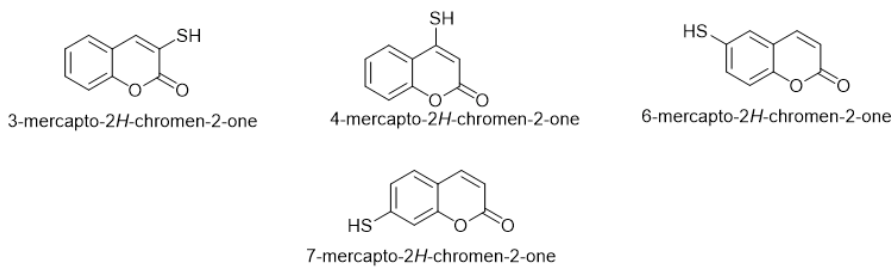
Figure 1. The four common mercapto-coumarin derivatives.